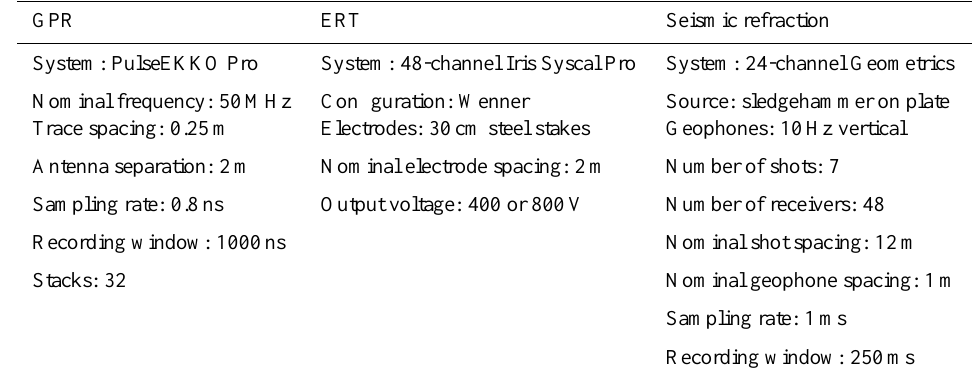
Table 1. Geophysical data acquisition parameters.